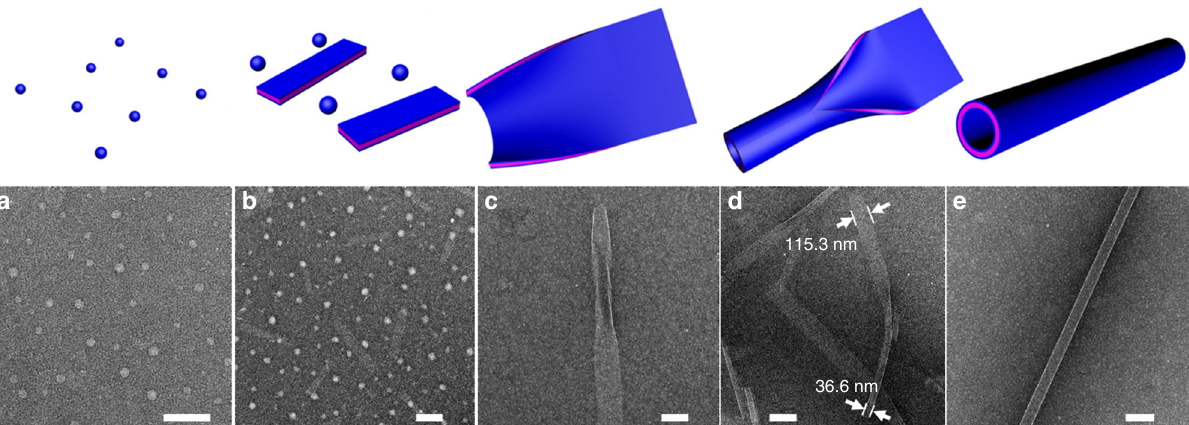
Fig. 2 Time-dependent TEM images showing the assembly pathway of APO2-PNTs. a TEM image of APO2 nanospheres (~26.2 nm in diameter), which were formed immediately after APO2 was completely dissolved in the mixture of H 2 O and CH 3 CN (scale bar, 200 nm). b TEM image showing APO2 assembled into a mixture of nanospheres (~44.9 nm in diameter) and nanoribbons (with a width of 75 – 120 nm and length of 200 – 600 nm) after 0.5 h crystallization (scale bar, 200 nm). c TEM image showing one nanoribbon with partially rolled up edges after 24 h crystallization of APO2 (scale bar, 100 nm). d TEM image shows that APO2 formed partially converted nanotubes after 48 h crystallization (scale bar, 200 nm); the measured width of one nanoribbon (about 115.3 nm) is 3.15 (approximately equal to π ) times the diameter of this closed nanotube (about 36.6 nm), which is in accordance with the circumference formula ( L = π D ). e TEM image showing the APO2-PNT formed after 72 h crystallization (scale bar, 100